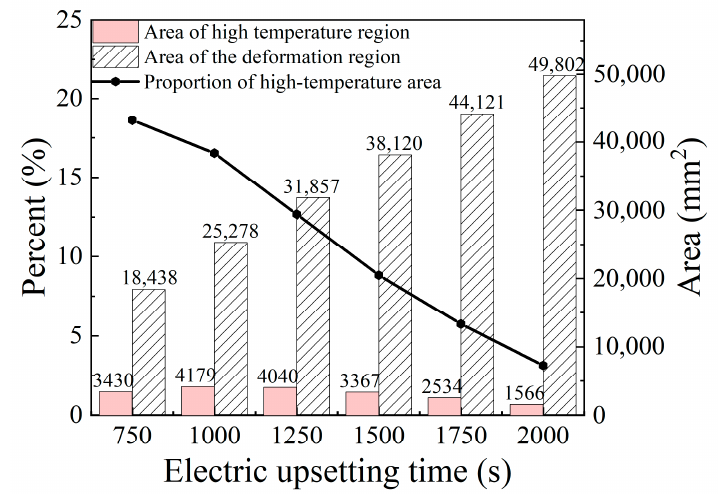
Figure 21. The area of the high temperature region and the onion area corresponding to diverse electric upsetting moments during the stable deformation stage.